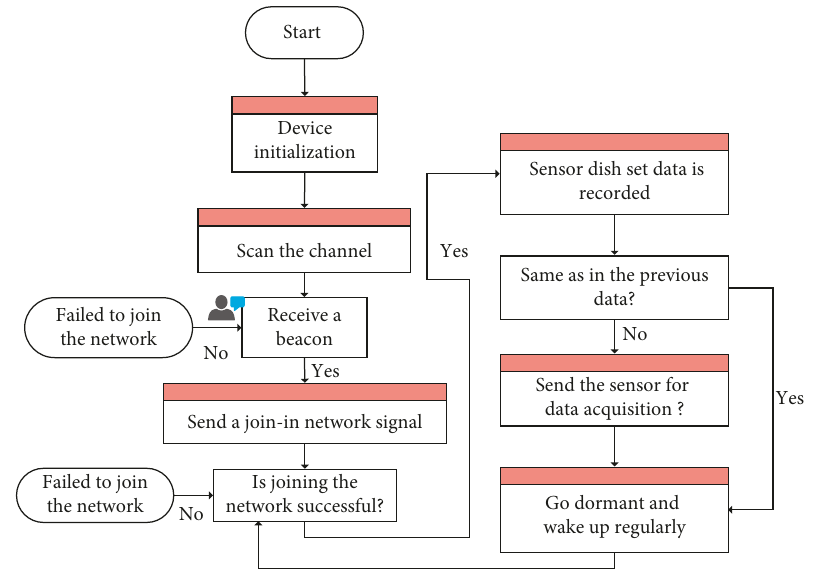
Figure 9: Working flow chart of sensor node.